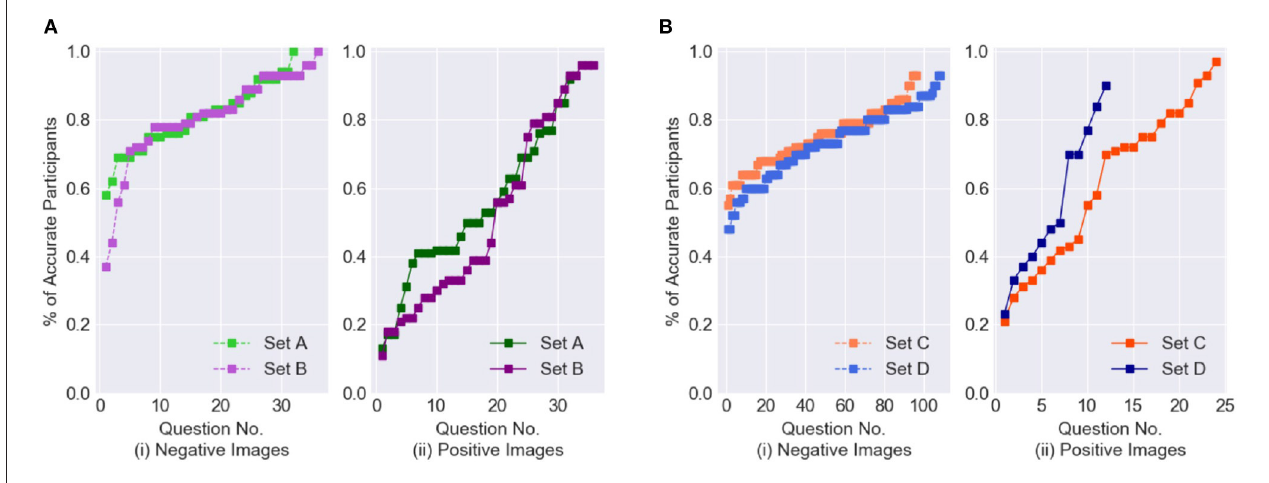
FIGURE 4 | Distribution of Binary Classification results from crowdsoured data. (A) Balanced dataset. (B) Imbalanced